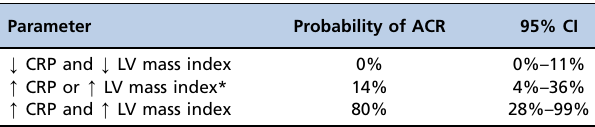
Table 3 - Predicted probabilities of ACR by CRP level and LV mass